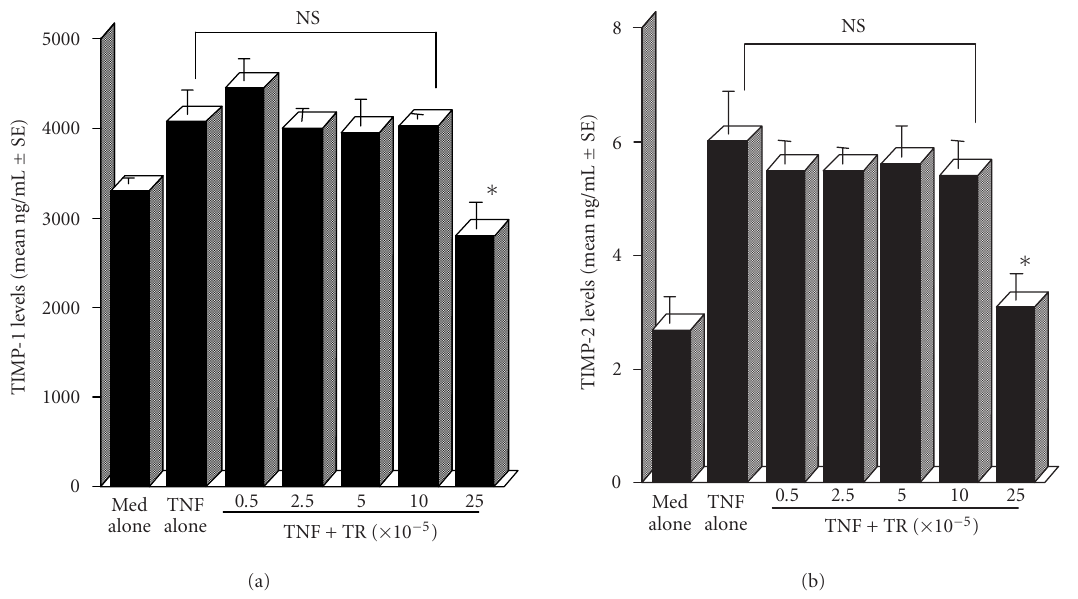
Figure 5. Influence of pretreatment of nasal fibroblasts with tranilast (TR) on the production of TIMP-1 and TIMP-2. Cells were treated with various concentrations of TR for 2 hours and then stimulated with TNF- α (TNF) for 24 hours. Data are expressed as the mean ng/mL ± SE of five di ff erent subjects. NS means not significant ( P > . 05); ∗ means significant ( P < . 05) compared with TNF alone.